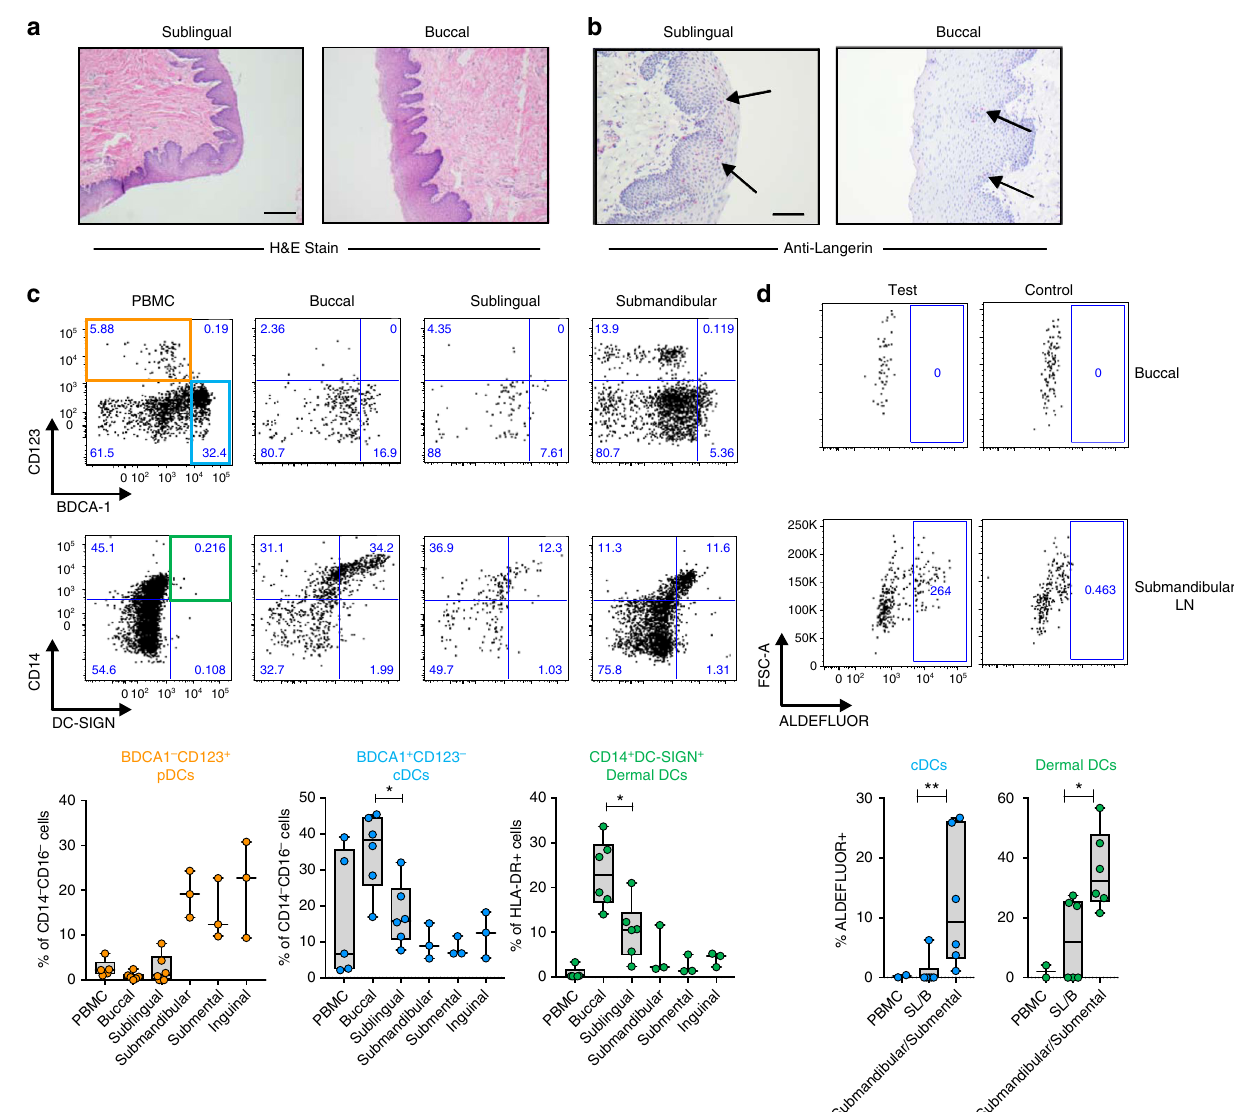
Fig. 1 Dendritic cells in the sublingual and buccal (SL/B) Tissue of rhesus macaques. Paraf fi n-embedded sublingual and buccal tissue sections were stained with a Hematoxylin and eosin and imaged by light microscopy (scale bar, 500 μ m) or b anti-Langerin and analyzed by immunohistochemistry (scale bar, 200 μ m). Arrows show Langerin + cells stained in red. c Representative fl ow plots showing dendritic cell (DC) subsets in PBMC, sublingual tissue, buccal tissue, and the submandibular, submental, and inguinal lymph nodes. Top row; CD45 + CD3 − CD20 − HLA-DR + CD14 − CD16 − cells were gated for plasmacytoid DC (CD123 + BDCA-1 − , orange) and conventional DC (CD123 − BDCA-1 + , blue) markers. Middle row; CD45 + CD3 − CD20 − HLA-DR + cells were gated for Dermal DCs (CD14 + DC-SIGN + , green). Bottom row; frequencies of DC subsets in different tissues (*, p < 0.05, Wilcoxon matched-pairs test). Data representative of samplings from six independent animals, n = 5 (PBMC) n = 6 (buccal, sublingual), n = 3 (submandibular, submental, and inguinal lymph nodes). Samples from the same animal were paired together. d Detection of aldehyde dehydrogenase (ALDH) activity in buccal or submandibular DCs using the ALDEFLUOR TM fl uorescent reagent. Control samples were used to set gating. Representative fl ow plots are shown on top measuring ALDH activity in conventional DCs in buccal tissue compared to submandibular lymph nodes. Bottom, frequencies of ALDEFLUOR + conventional DCs (blue) and dermal DCs (green) in PBMCs ( n = 2), buccal ( n = 3) and sublingual tissue ( n = 3), and submandibular ( n = 3) and submental lymph nodes ( n = 3) (*, p < 0.05; **, p < 0.01; Mann – Whitney test). PMBC, peripheral blood mononuclear cells; SL/B, sublingual and buccal tissue. Box and whiskers plot in c , d ; box extends from 25th to 75th percentile, the line indicates median, whiskers indicate min and max